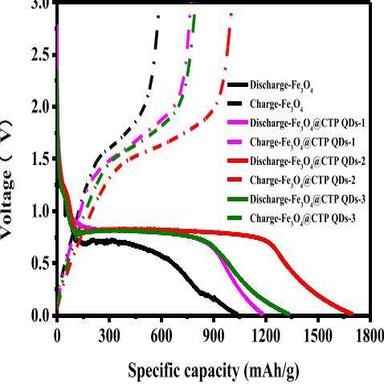
Initial charge/discharge curves of pure Fe3O4 and Fe3O4@CTP QDs composite electrodes in the first cycle at 100 mA g−1.